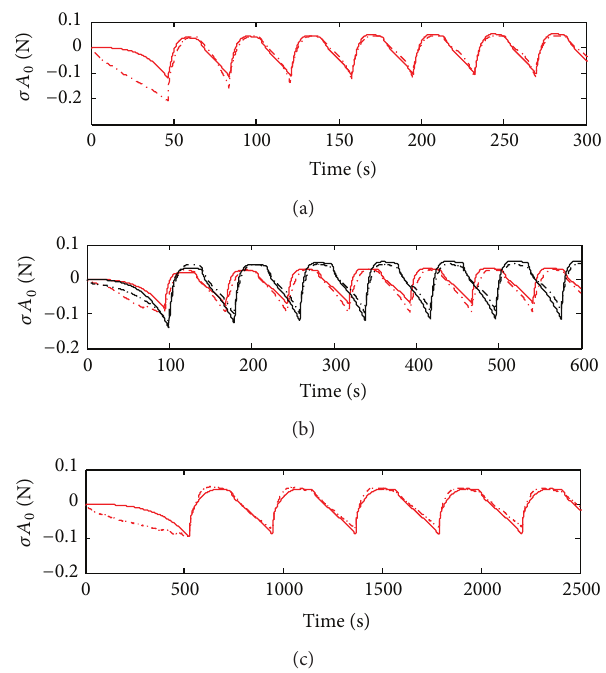
Figure 9: Block-oriented Hammerstein model system identification using a polynomial static function of order three. The structure is given by (10) using 𝑢 󸀠 = 𝑓(𝑢) = 𝑓(𝜀) as input. (a) shows the identification data. (b) and (c) show validation data of samples 2, 3, and 4 using the colors and lines code of Figures